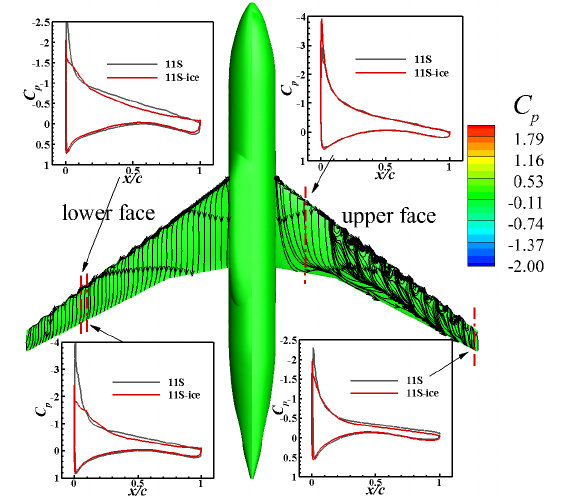
Figure 12. Flow field changes of 11S before and after ice accumulation.